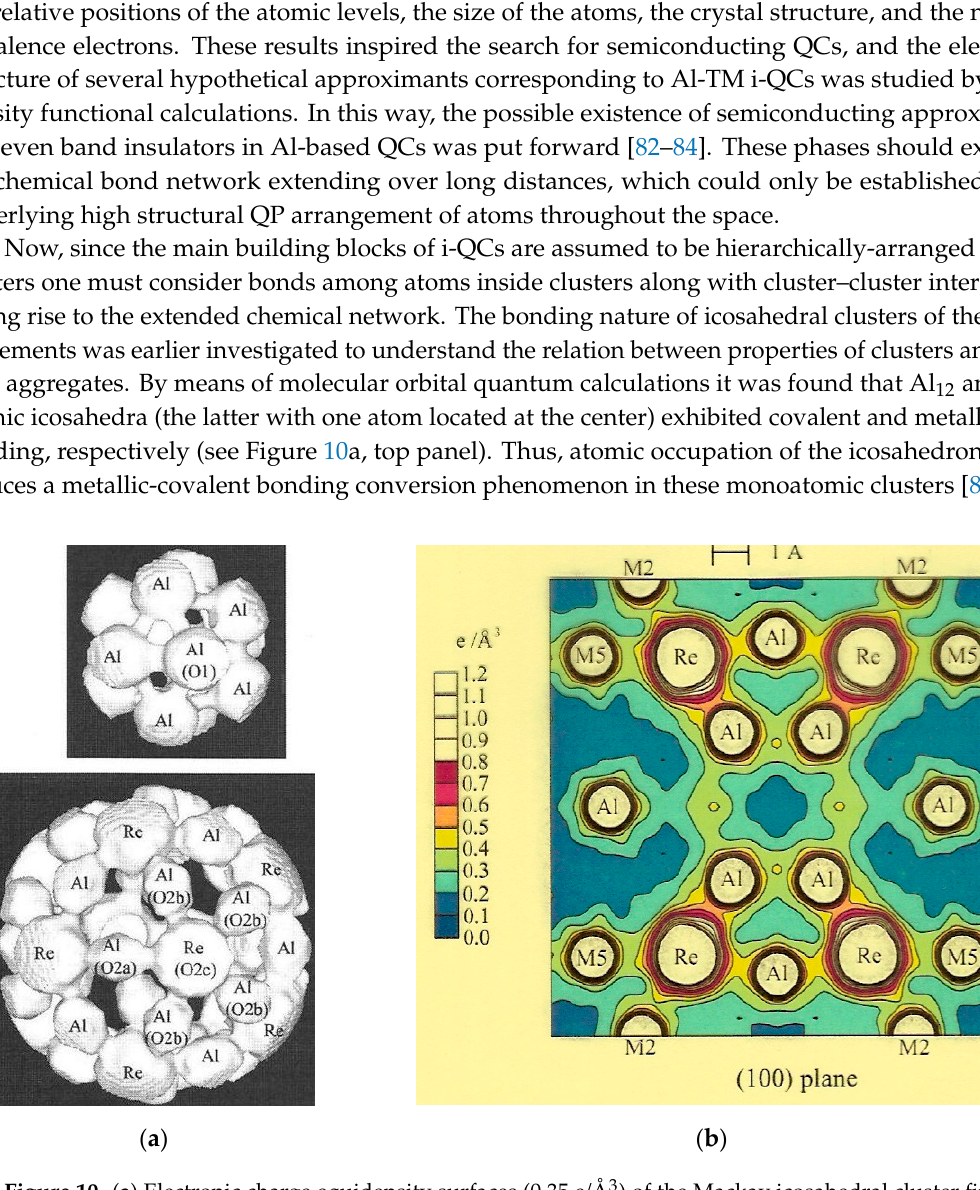
Figure 10. ( a ) Electronic charge equidensity surfaces (0.35 e/Å 3 ) of the Mackay icosahedral cluster first (top panel) and second (bottom panel) shells in the α -AlReSi approximant crystal; ( b ) section contour map of charge density of α -AlReSi in the range 0.00–1.20 e/Å 3 , with a step of 0.10 e/Å 3 . (Reprinted figure with permission from Kirihara, K.; Nakata, T.; Kimura, K.; Kato, K.; Takata, M.; Kubota, Y.; Nishibori, E.; Sakata, M. Covalent bonds and their crucial effects on pseudogap formation in α -Al(Mn,Re)Si icosahedral quasicrystalline approximant. Phys. Rev. B 2003 , 68 , 014205 Copyright (2003) by the American Physical Society).